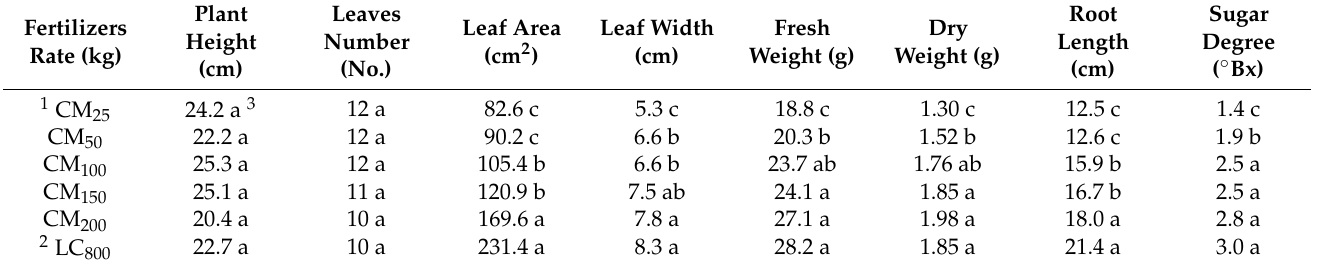
Table 3. The traits of Pak Choi by the treatments of organic fertilizers.